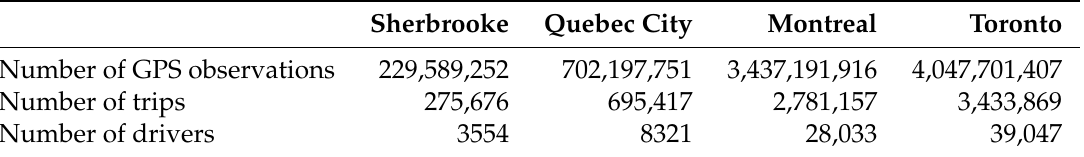
Table 2. Statistics of the data